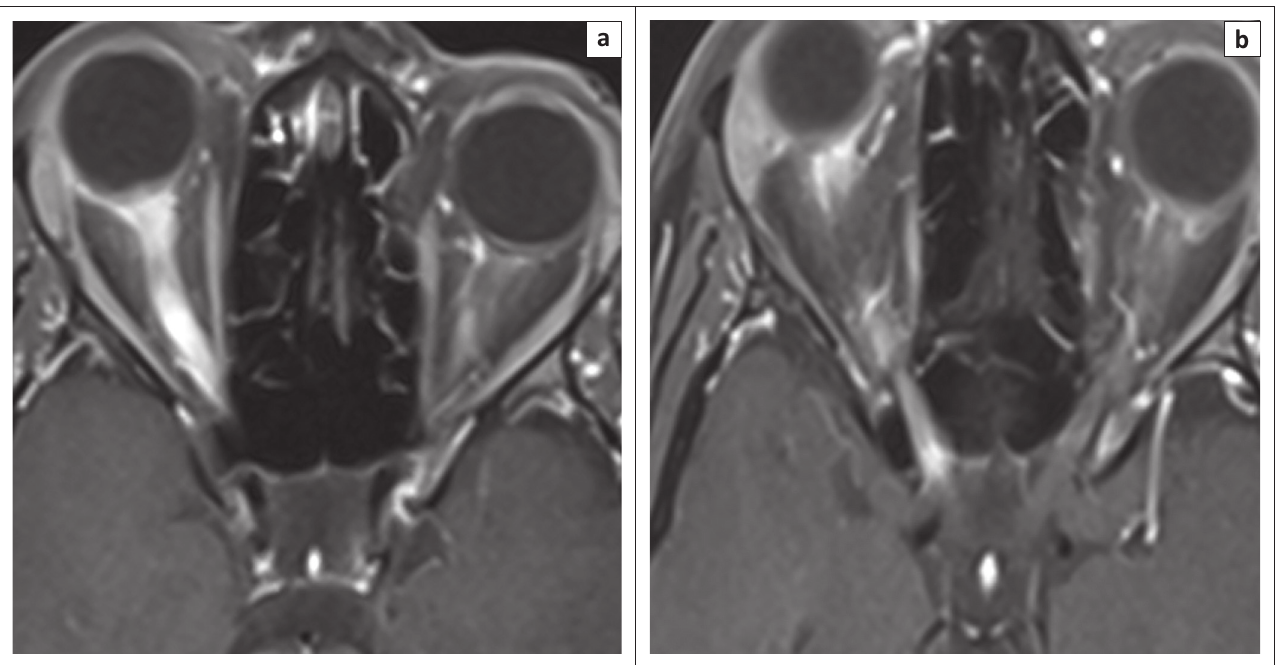
FIGURE 2: (a) and (b) are orbital MRI views post-contrast. They show diffuse enhancement of the right optic nerve extending to the chiasm (arrows). Minimal enhancement of the left optic nerve is also present (right arrow in (b)).